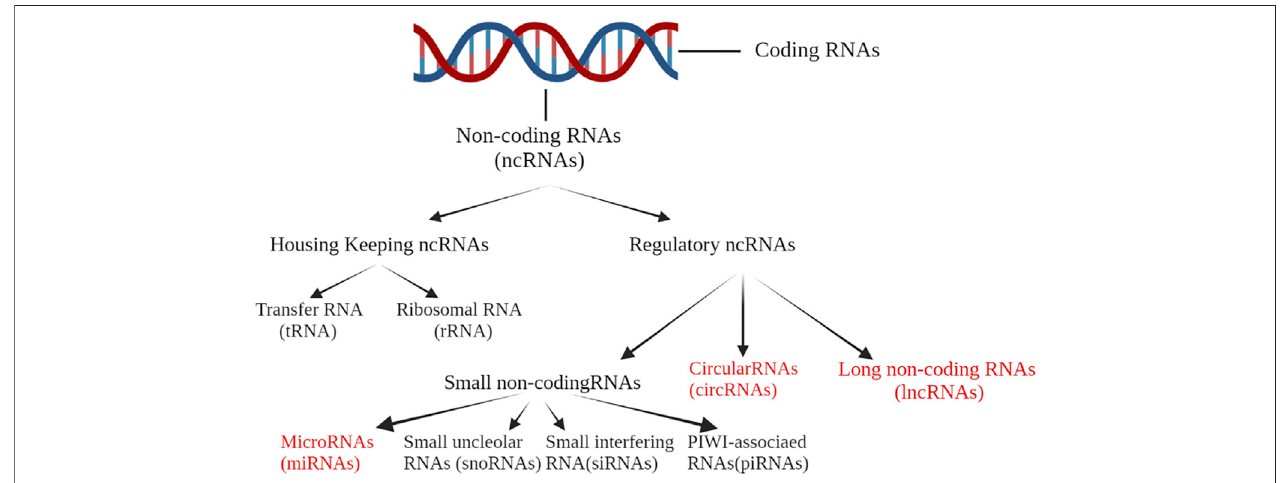
FIGURE 2 | Less than 2% of the human genome is transcribed into mRNA with protein-encoding functions. For the rest of the human genome, more than 80% is transcribed into RNA without protein-encoding potential. Such functional genomic transcripts are called ncRNA. NcRNAs mainly include microRNA (miRNA), long non- coding RNA (lncRNA), circular RNA (circRNA), small nucleolar RNA (snoRNA), PIWI-associated RNAs (piRNAs) and transfer RNA